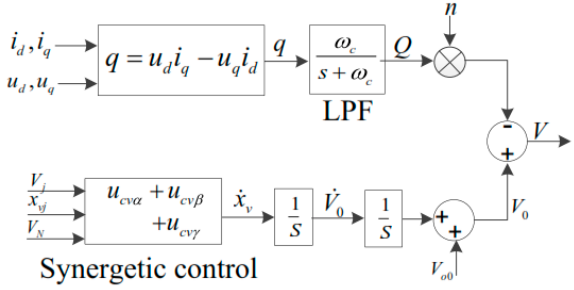
Figure 8. Diagram of adaptive voltage droop control.